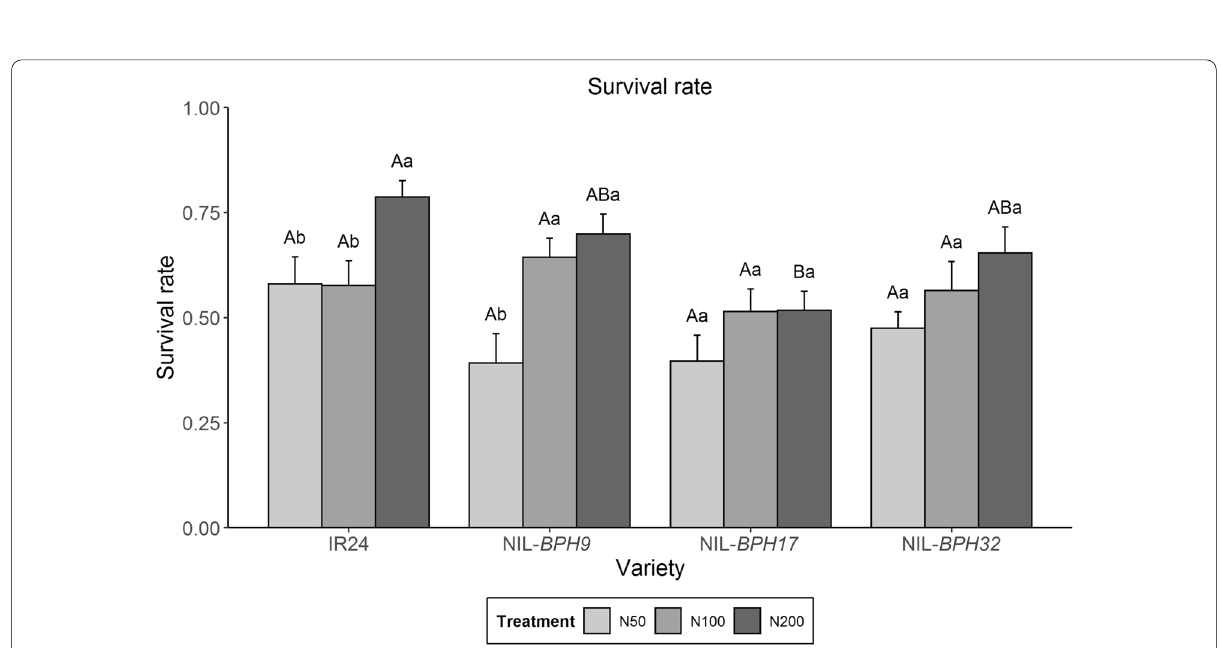
Fig. 4 Nymph survival rate of N. lugens feeding on IR24, NIL‑ BPH9 , NIL‑ BPH17 , and NIL‑ BPH32 under different nitrogen regimes. Means in each column followed by the same capital letter do not differ significantly among varieties ( p < 0.05). Means in each column followed by the same lowercase letter do not differ significantly among different nitrogen treatments. The error bars indicate the